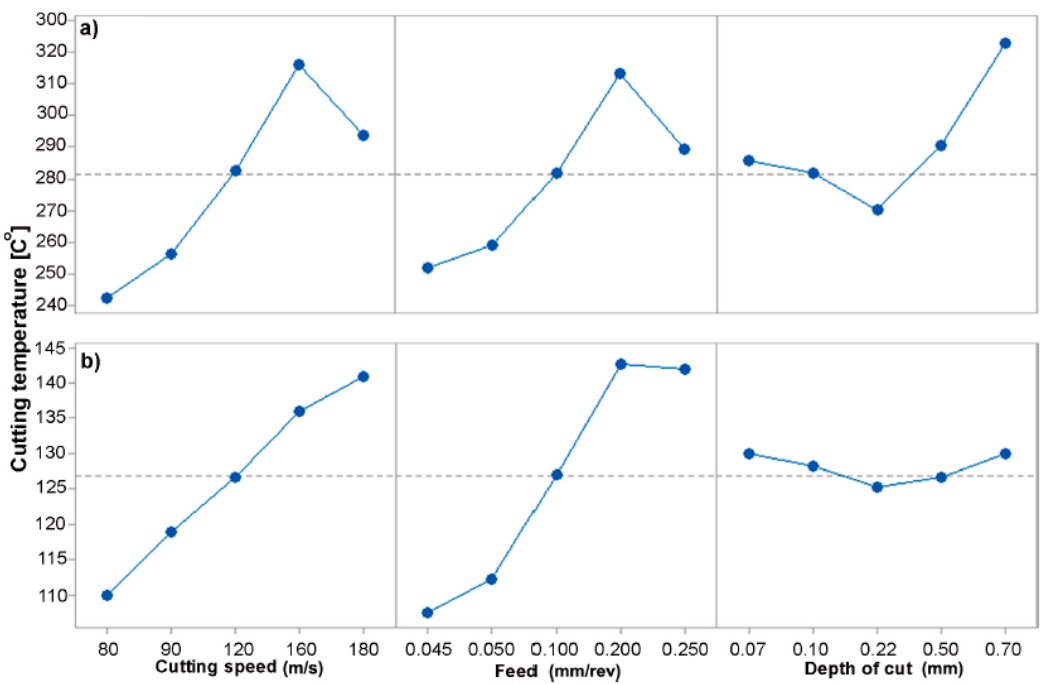
Figure 4. Main e ff ect plot for cutting temperature with di ff erent tools: ( a ) HM and ( b ) CBN.